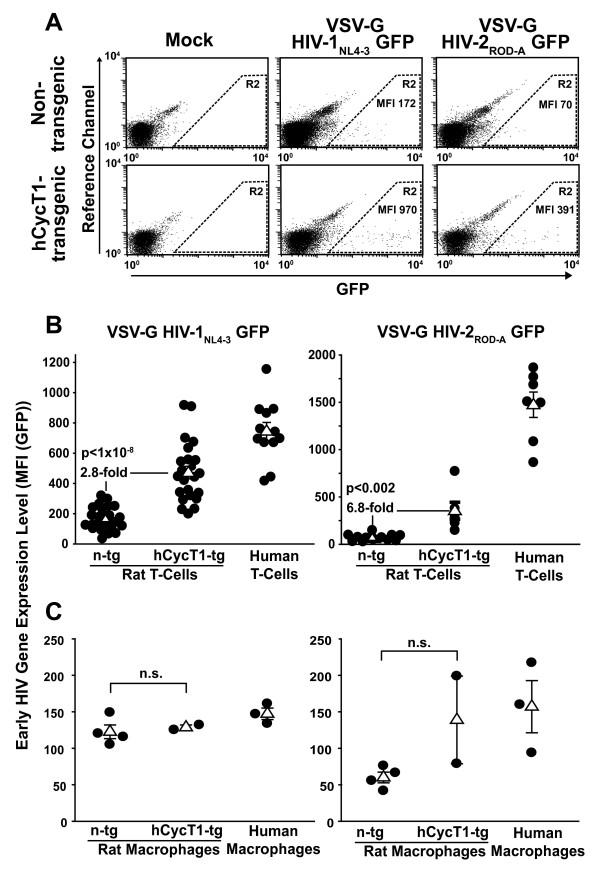
hCycT1 transgenesis boosts early HIV gene expression in infected primary T-cells, but not in macrophages. (A, B)Activated T-cells from hCycT1-tg and n-tg rats were infected with VSV-G HIV-1NL4-3 or HIV-2ROD-A GFP reporter viruses and analyzed by flow cytometry three days later. (B, C) Cumulative results from several independent infection experiments of cells derived from rats or human donors. Closed circles depict the MFI of (B) HIV-infected T-cells or (C) HIV-infected macrophages as the mean of triplicates of experiments performed for cultures from individual donors. Open triangles represent the arithmetic mean of the MFI of all donors in one group ± SEM. n.s. = not significant.